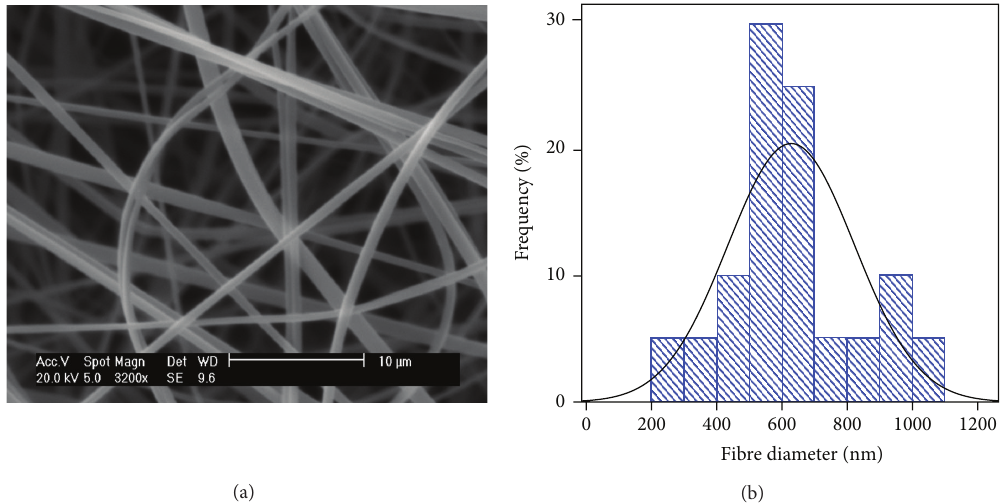
Figure6:SEMmicrographofCAwebproducedfromthebinarysolventsystemacetone:DMAcatapolymerconcentrationof25%(w/v).